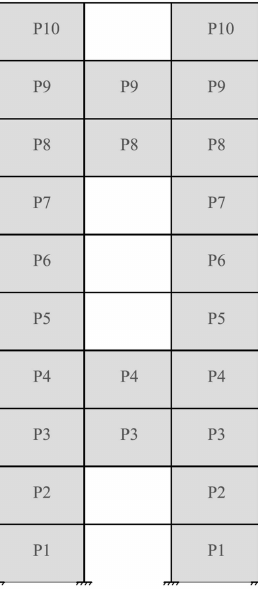
Figure 11. Best configuration of SPSW of SPSW3-10.